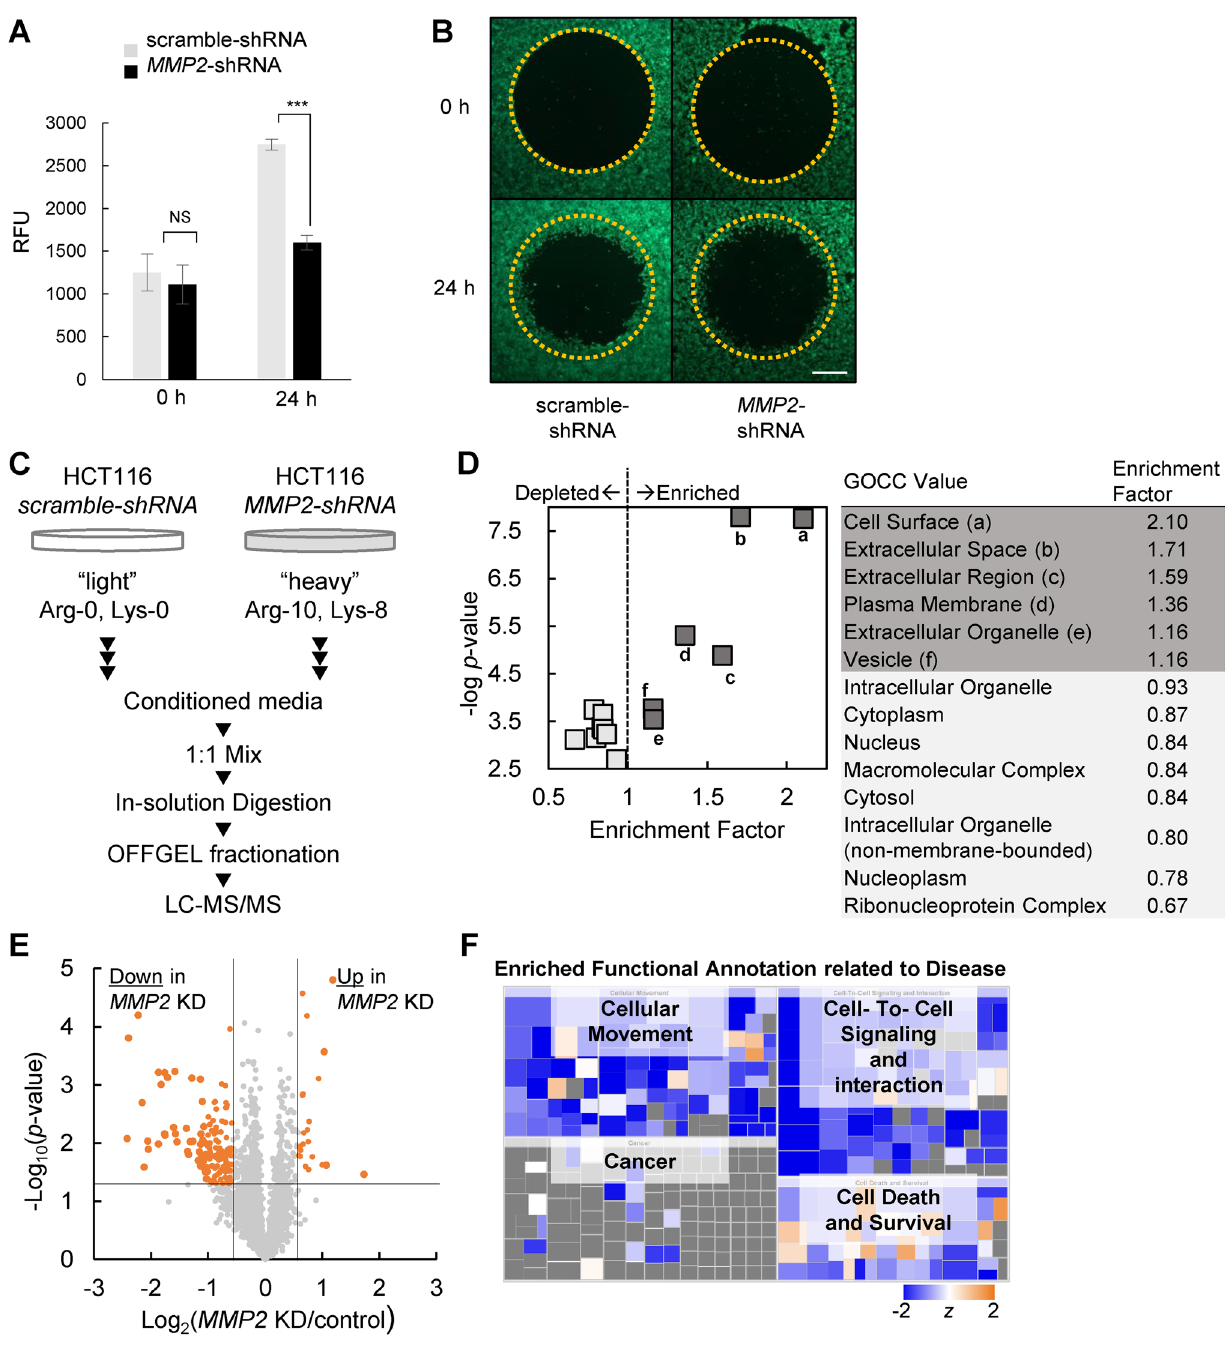
Figure 2. Analysis of differentially secreted proteins in HCT116 cells upon MMP2 KD. ( A ) Quantification of cell migration of HCT116 cells upon MMP2 KD. The error bars represent ± standard deviation (SD) (NS: not significant. ***: p < 0.001). ( B ) Representative fluorescence images of HCT116 cells showing cell migration activity at the indicated time after stopper. Dotted circles represent the initial stopper position. Scale bar, 500 µm. ( C ) Schematic workflow of the SILAC-based quantitative proteomic analysis of the HCT116 secretome. The experiments were performed three times with this setup and three more times with the reverse setup, i.e. HCT116 MMP2 KD with light SILAC. ( D ) Gene ontology enrichment analysis was performed for the proteins identified as quantifiable at least three times out of six replicated SILAC experiments compared to all human proteins as the background list using Fisher’s exact test (Benjamini–Hochberg FDR < 0.02). ( E ) Volcano plot for the SILAC-quantitation values of the cell secretome. Orange dots indicate proteins with a Benjamini–Hochberg FDR < 0.05 and a fold change above ± 1.5. ( F ) Functional annotation of the differentially secreted proteins by using IPA. The blue color represents inactivation of the indicated annotation upon MMP2 KD while the orange color represents activation. All quantified proteins were used as the background and Benjamini–Hochberg FDR < 0.02 was applied. Box size represents –log ( p